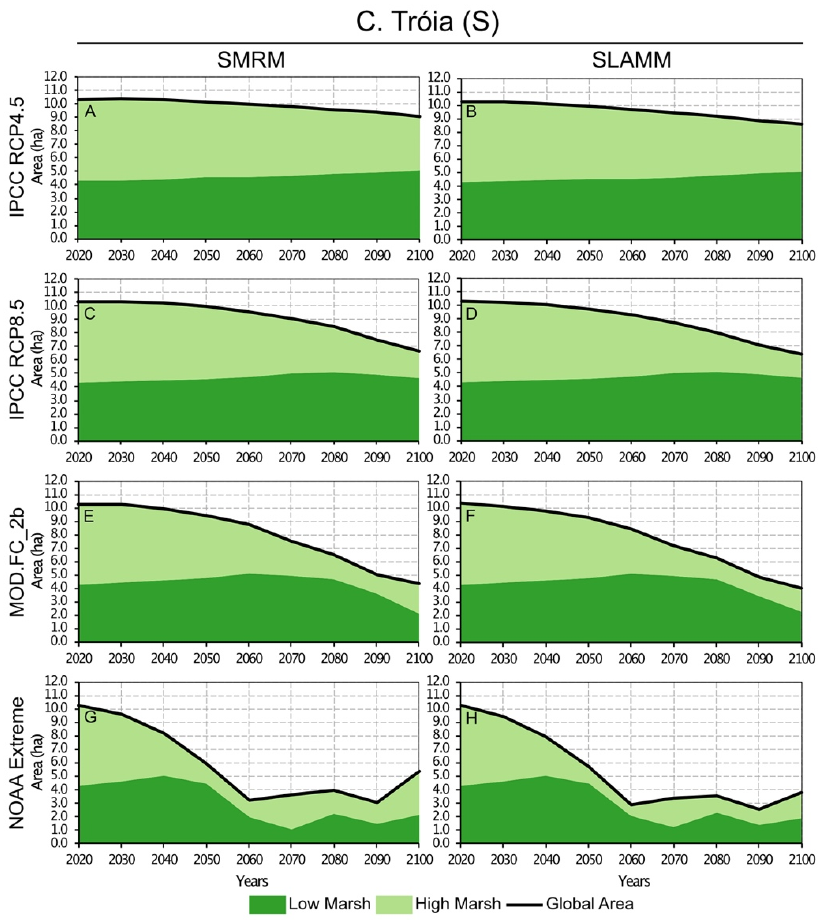
Figure 8. C. Tróia (S) decadal area evolution until 2100, using SMRM and SLAMM, respectively, considering IPCC RCP4.5 ( A , B ), IPCC RCP8.5 ( C , D ), MOD.FC_2b ( E , F ), and NOAA Extreme ( G , H ). The SMRM with the MOD.FC_2b SLR scenario (111 cm until 2100) produces major changes until the end of the century. In C. Tróia (N), the area will be reduced by 3% (4.36 ha) and 58% (1.89 ha) (Figure 6E) and the HM/LM ratio will be 1.4 and 0.7 until 2050 and 2100 (Figure 7I,K). For C. Tróia (S), the losses will be almost identical: the area will be reduced by 8% (9.44 ha) and 57% (4.39 ha) in 2050 and 2100 (Figure 8E). However, the HM/LM ratio will be 1.0 and 1.1, respectively (Figure 9I,K). SLAMM produces area losses of 3% and 61% for C. Tróia (N) (Figure 6F) (HM/LM = 1.3/0.5 for 2050/2100—Figure 7J,L) and of 11% and 61% for C. Tróia (S) for the reference dates (Figure 8F) (HM/LM = 0.9/0.8 for 2050/2100—Figure 9J,L). Finally, considering SMRM with NOAA Extreme (261 cm of SLR until 2100), the area will be reduced by 24% (3.42 ha) and 72% (1.24 ha) in 2050 and 2100 in C. Tróia (N) (Figure 6G). The HM/LM will be 0.3 and 1.2, showing a recovery by the end of the century (Figure 7M,O). In C. Tróia (S), the losses in the area will be almost the same in 2050 and 2100: 42%